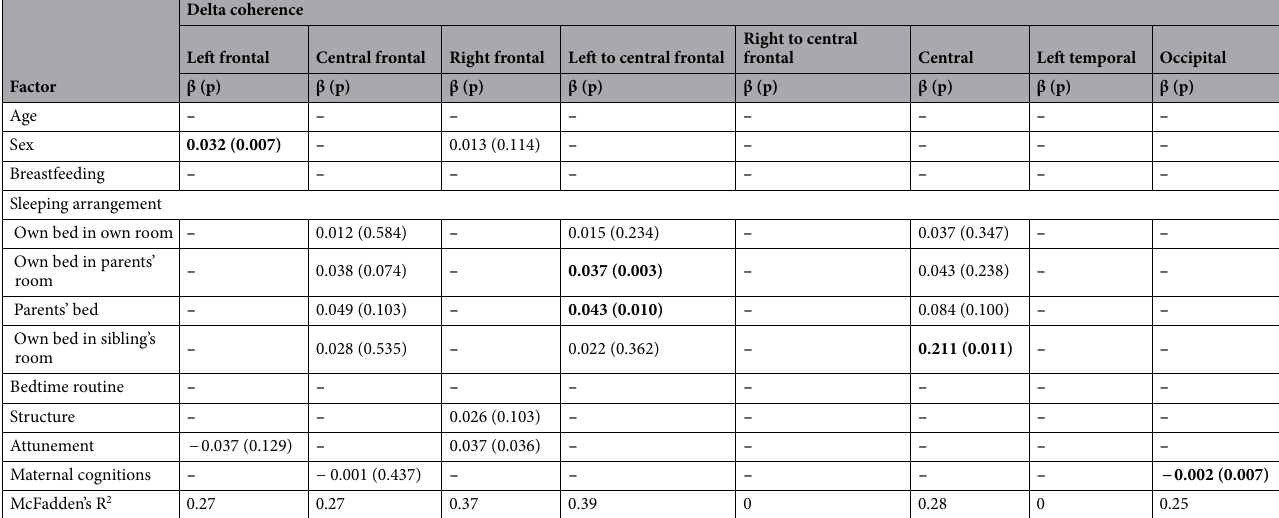
Table 2. Associations of sleep EEG coherence in the non-rapid eye movement (NREM) sleep delta band with age, sex, frequency of breastfeeding and the familial factors regarding infant sleep habits (sleeping arrangement and bedtime routine), caregivers’ principles regarding structure and regularity of their infant’s sleep (structure and attunement), and caregivers’ anxiety regarding their infant’s sleep (maternal cognitions). Sex was coded such that positive coefficients represent larger values in females. For the sleeping arrangement, the category “Other” served as the reference. Unstandardized beta coefficients (b) and uncorrected p-values (p) from linear regression models are shown. For factors that did not survive selection, these values are missing. Effects that remained significant after correcting for multiple comparisons by means of false discovery rate are bolded. The last row shows McFadden’s R 2 indicating that the models improved the explained variance of the null model by 25 to